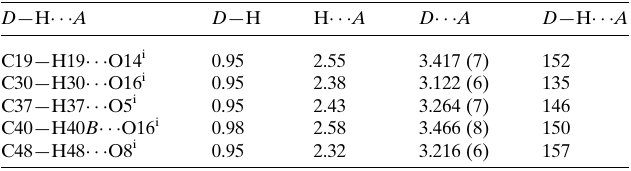
Table 1 Hydrogen-bond geometry (A˚ , (cid:4) ).